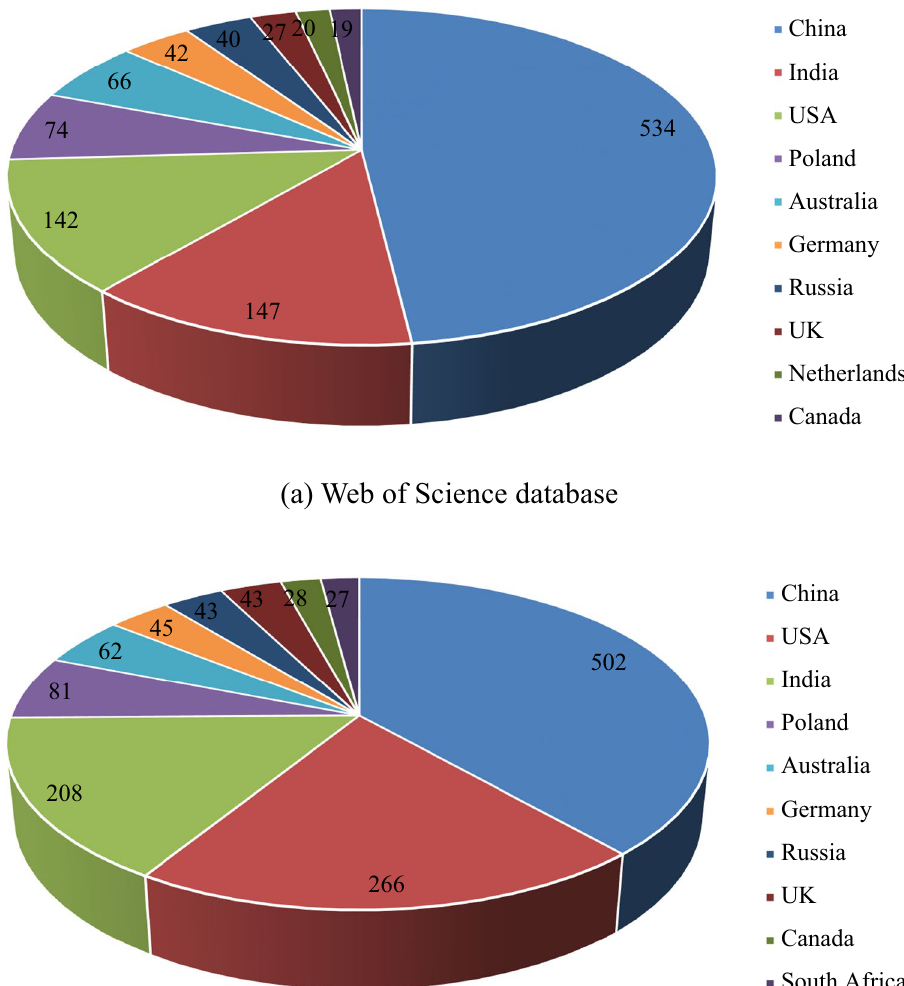
Fig. 3 Quantity of published literature related to underground coal fires in different